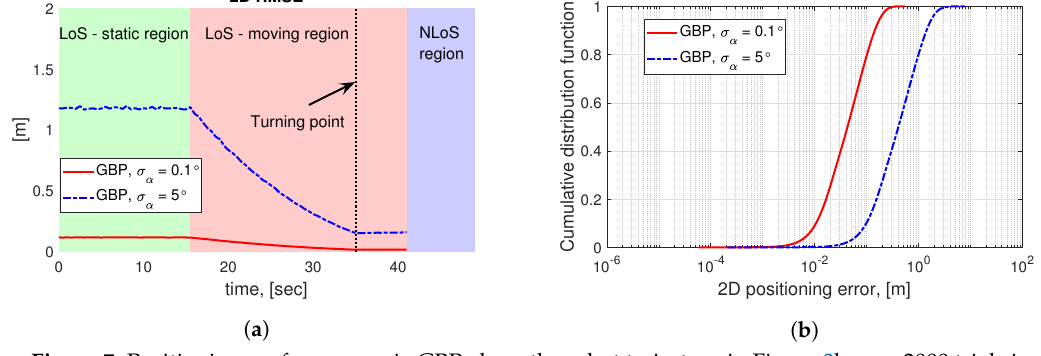
Figure 7. Positioning performance via GBP along the robot trajectory in Figure 3b over 2000 trials in the simulation campaign. It is noteworthy that the timeline of Figure 6a is slightly different than that of Figures 8 and 9, which are obtained from the experiment. The reason lies in the fact that the ground truth of the robot trajectory is unknown in the experiment but is defined in the simulation campaign.